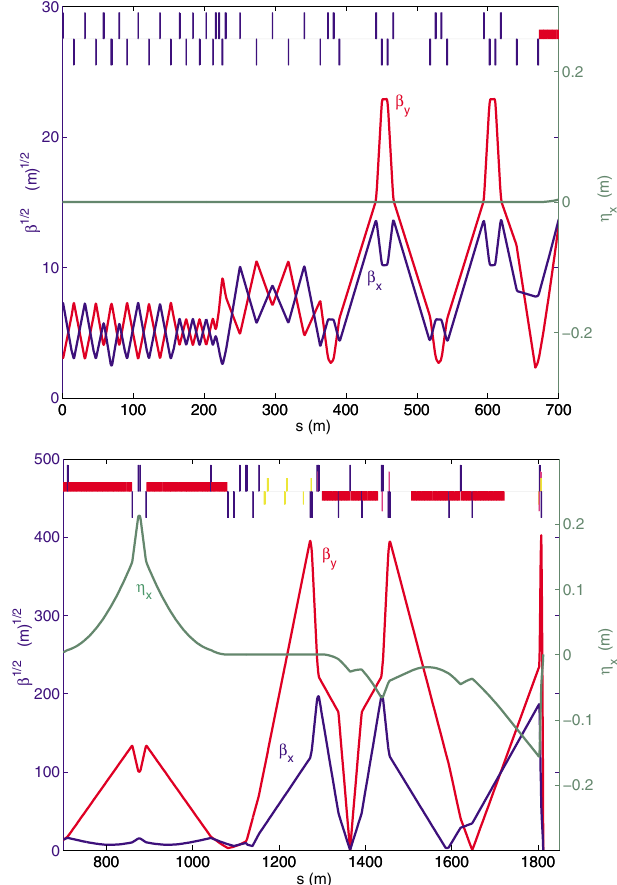
FIG. 1. (Color) Optics of the Next Linear Collider (NLC) beam delivery system. The IP is located at s (cid:3) 1812 : 56 m . A skew correction section is located in the first hundred meters. Correction sextupoles, whose displacements form the linear knobs, are at maxima of the beta function near s (cid:3) 1270 and 1450 m and in the FD.